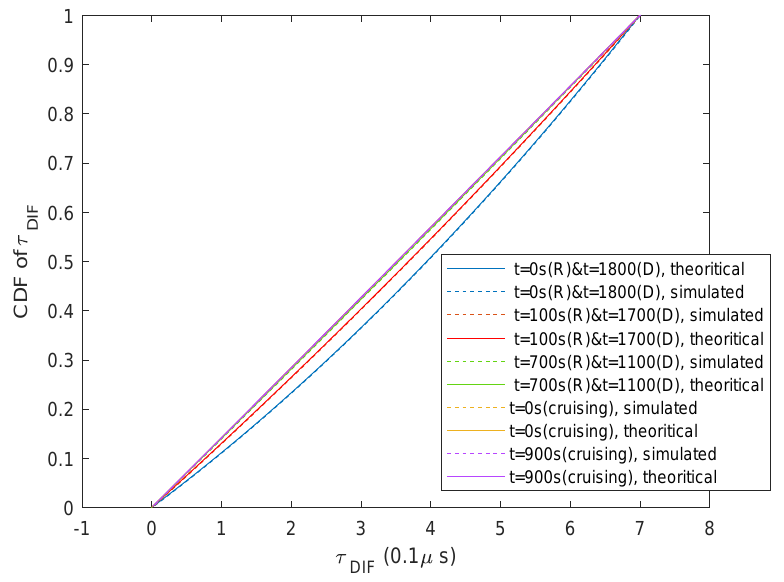
Figure 12. The CDF of relative time